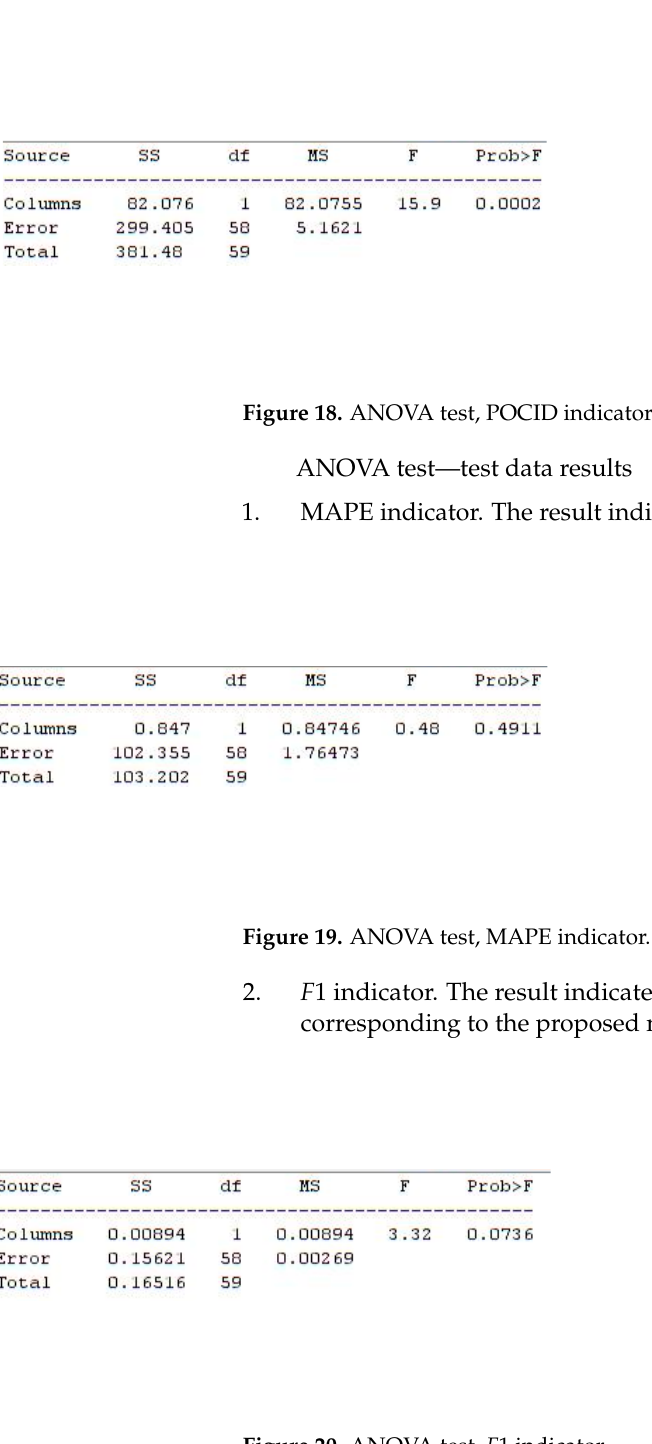
Figure 20. ANOVA test, F 1 indicator.